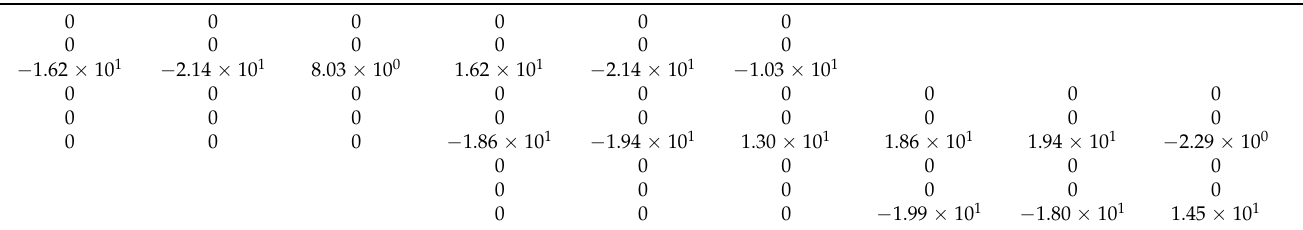
Table 7. Third term K III in the deformed configuration obtained applying F 2 y = 50 ( µ N). T